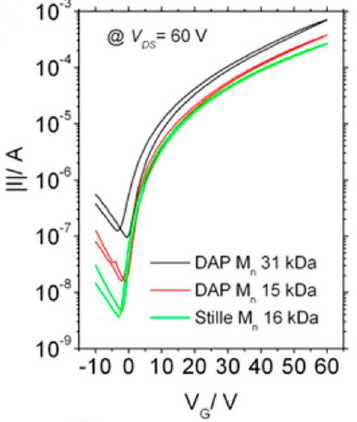
Figure 4. Transfer curves for transistors made from N2200 ( P2 ), comparing batches from Stille and DHAP methods. Reproduced with permission from ( J. Am. Chem. Soc. 2015 , 137 , 6705–6711). Copyright (2015) American Chemical Society.